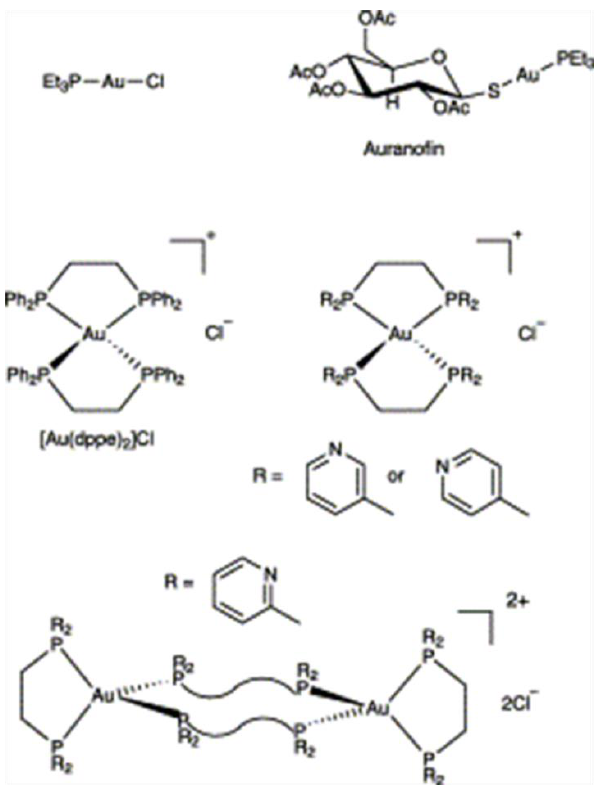
Figure 7. Chemical structures of some gold(I) – phosphine complexes. Reprinted with permission from Ref. [101]. Copyright © 1981 American Chemical Society.